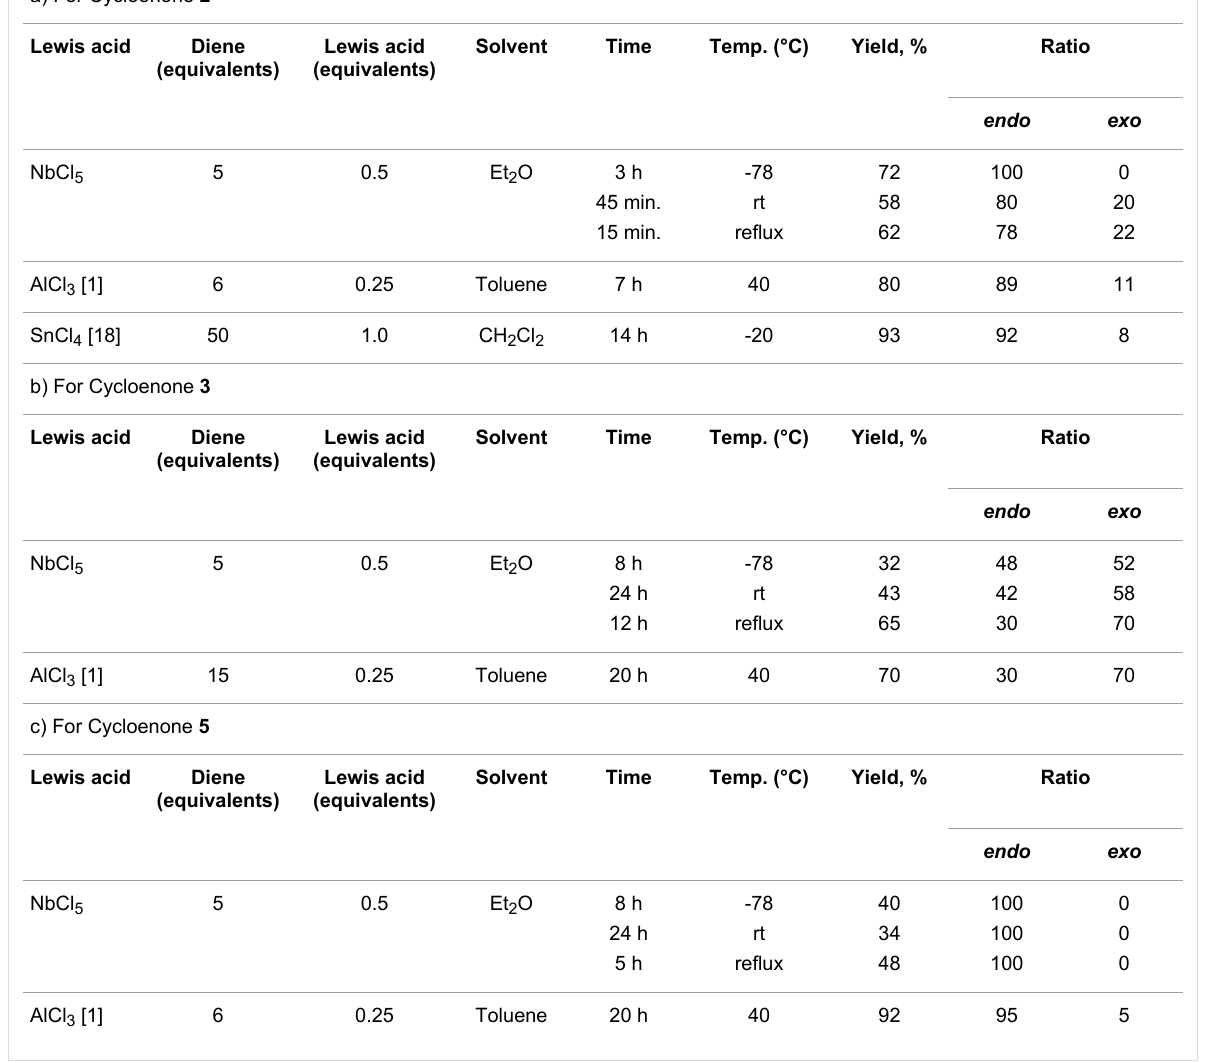
Table 2: Comparison between Diels-Alder reactions of 2-cycloenones with cyclopentadiene catalyzed by NbCl 5 , AlCl 3 [1] and SnCl 4 [18]. a) For Cycloenone